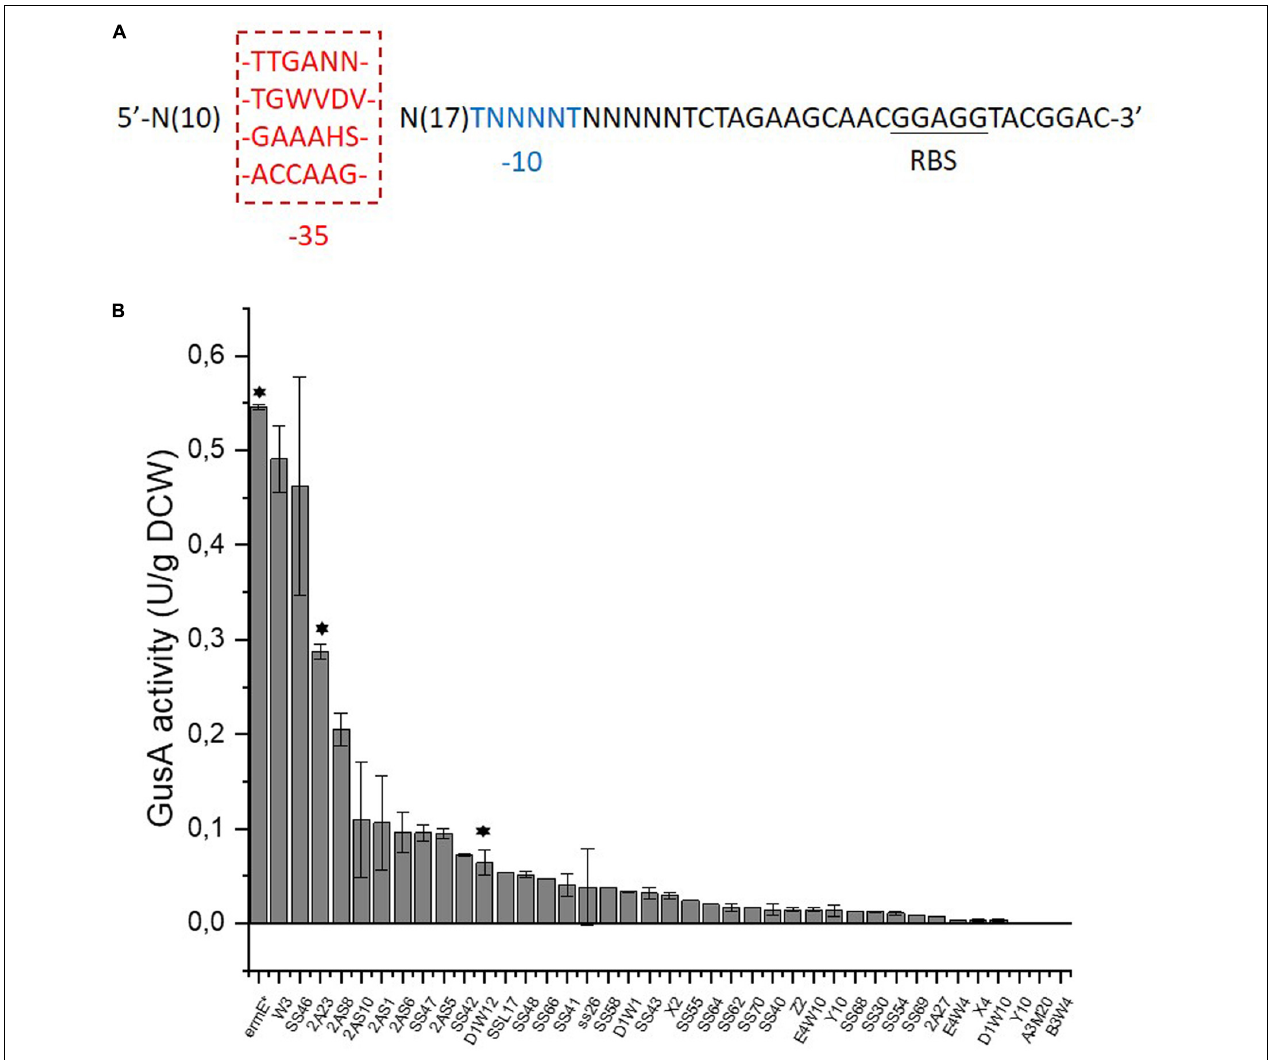
FIGURE 1 | Construction of a synthetic promoter library in S. erythraea . (A) , four sets of templates for the construction of a SPL. -35 or -10 region is in red or blue, respectively. Ribosome binding site (RBS) is underlined. The degenerate nucleotides: N = A/C/G/T, W = A/T, V = A/C/G, D = A/G/T, H = A/C/T, S = C/G. (B) , characterization of promoter strength shown as the total GusA activity per gram of dry cell weight (DCW). Asterisks above bars indicate that these promoters would be used to drive the expression of